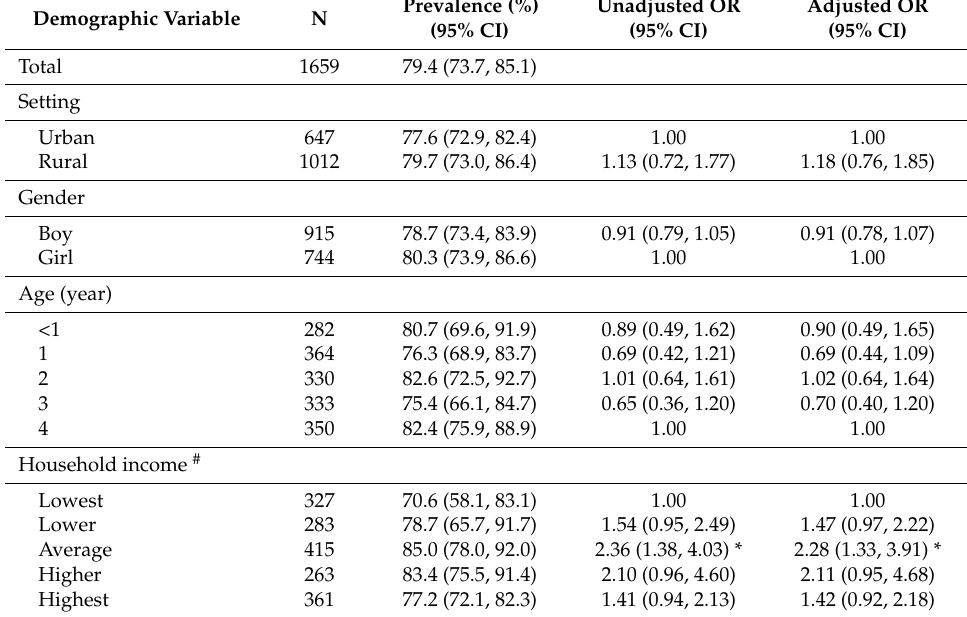
Table 1. Weighted prevalence of having ever been breastfed among children under 5 years of age and associations with demographic factors (Hunan Province of China,